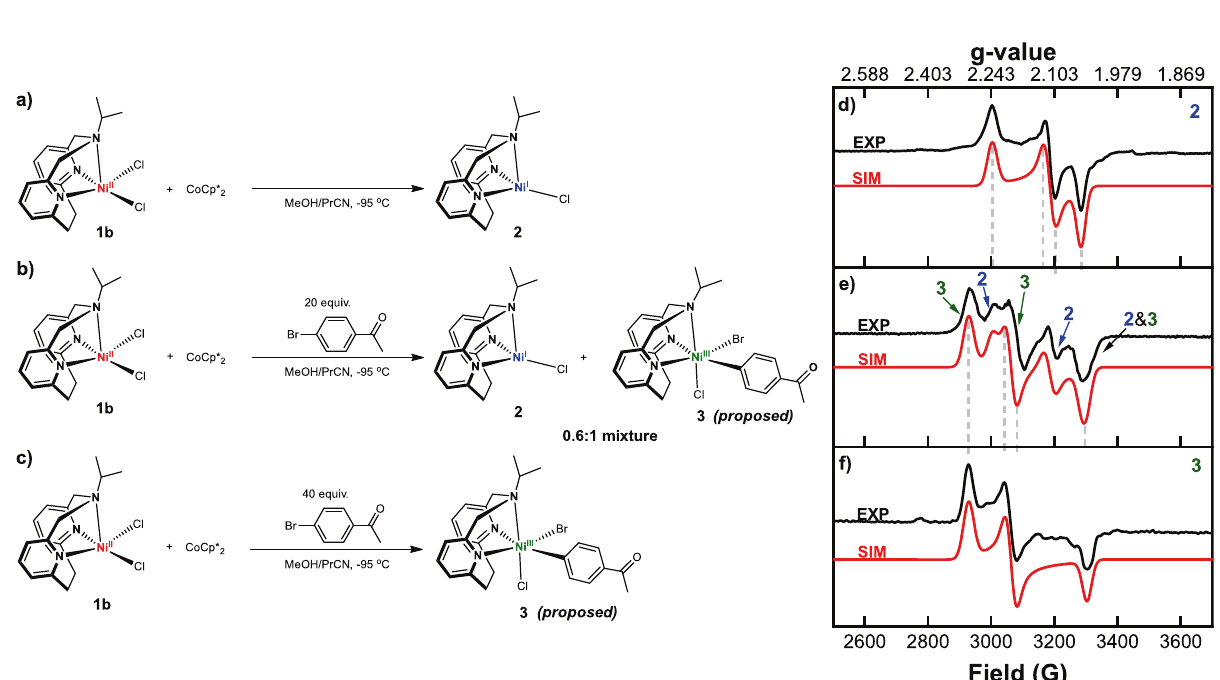
Fig. 4 EPR studies of the Ni I species. a – c (left) Experimental setup for EPR detection of proposed Ni I and Ni III species upon reduction of 1b and subsequent oxidative addition of aryl bromide. (right) Experimental (black) and simulated (red) EPR spectra of the reaction mixtures recorded at 77 K in 1:5 MeOH:PrCN frozen glass: d 1b + CoCp* 2 , e 1b + CoCp* 2 + 20 equiv 4-bromoacetophenone, f 1b + CoCp* 2 + 40 equiv 4-bromoacetophenone. The following parameters were used for simulation of d g x = 2.241, g y = 2.113, g z = 2.049; f g x = 2.298, g y = 2.197, g z = 2.037; e the simulations in d and f were added in a 0.6:1 ratio. The structure proposed for species 3 is